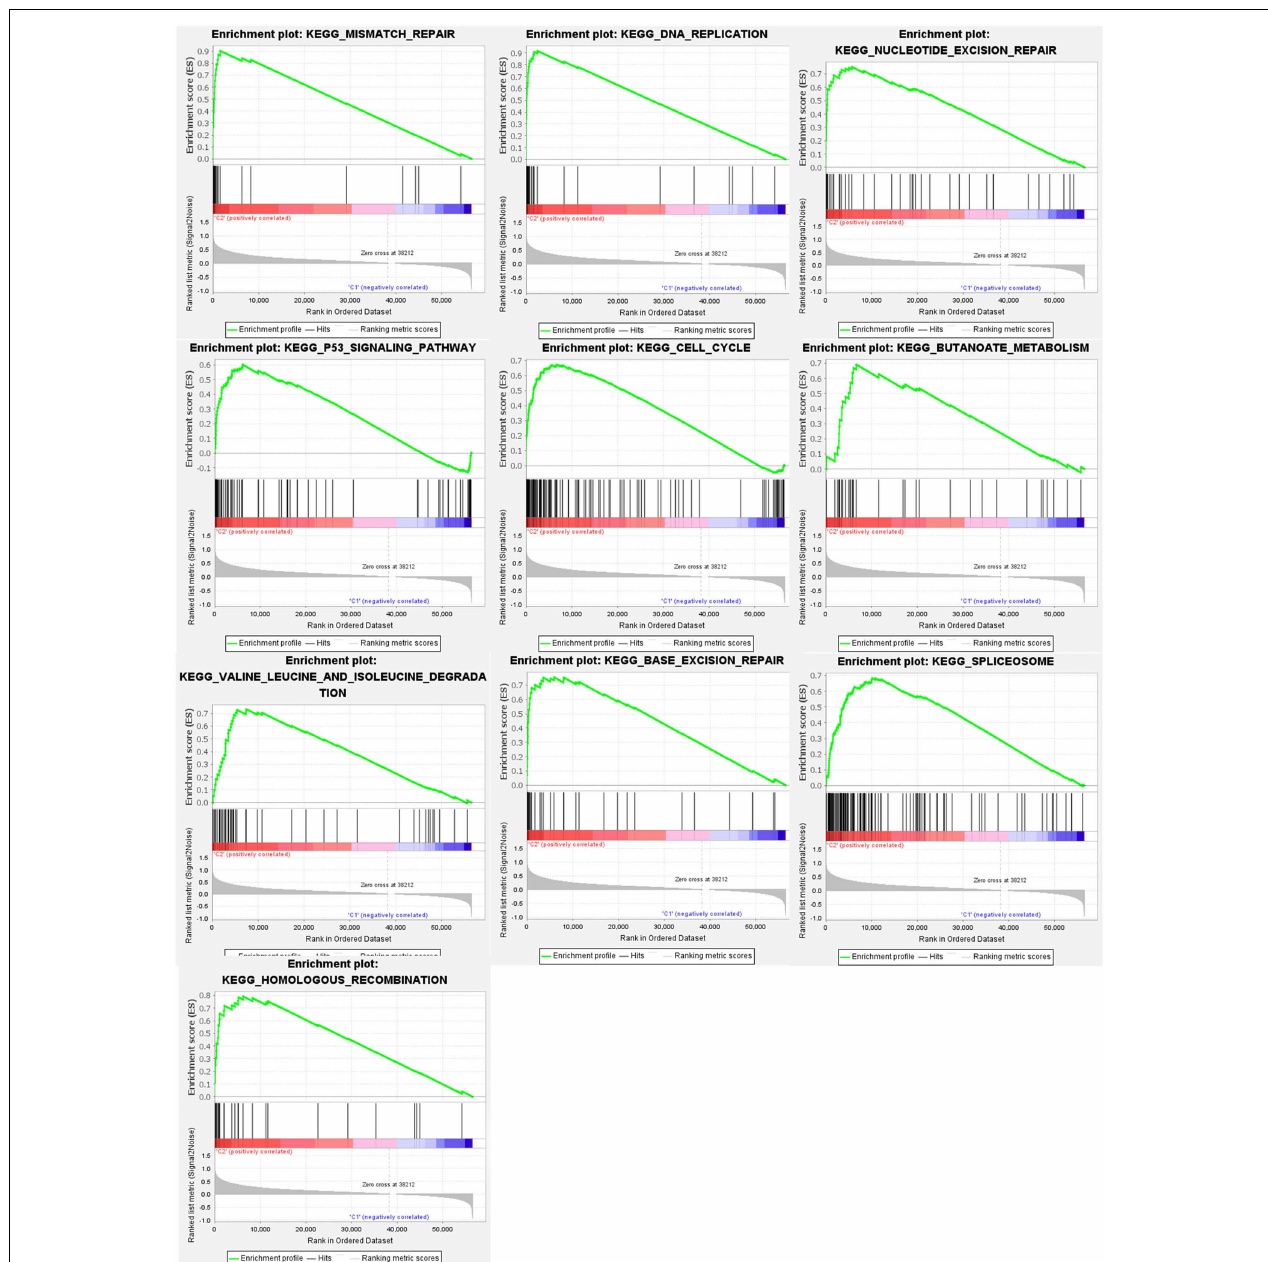
FIGURE 5 | Gene set enrichment analysis (GSEA) was conducted to predict the potential functions and pathways between the two clusters.